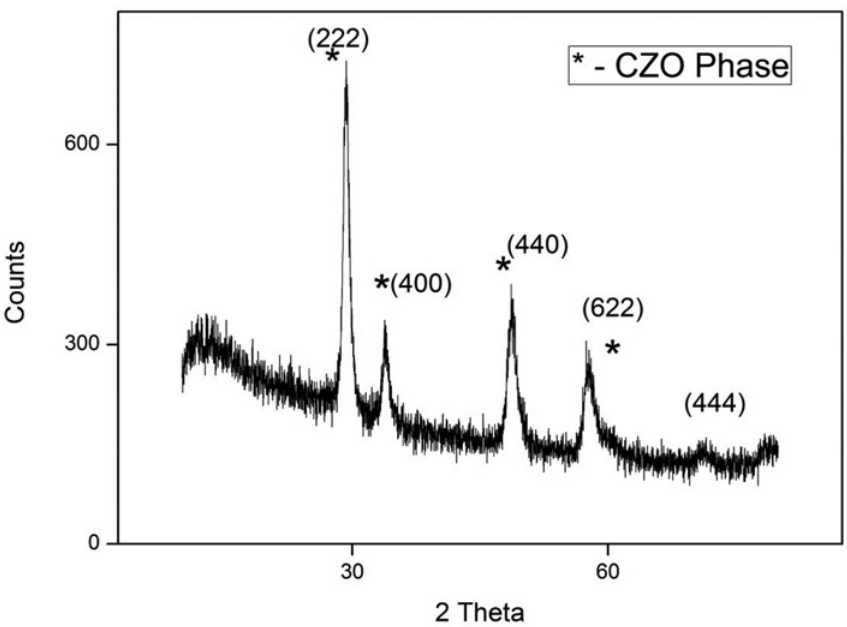
Figure 2: XRD analysis of synthesized Ce 2 Zr 2 O 8 powders.